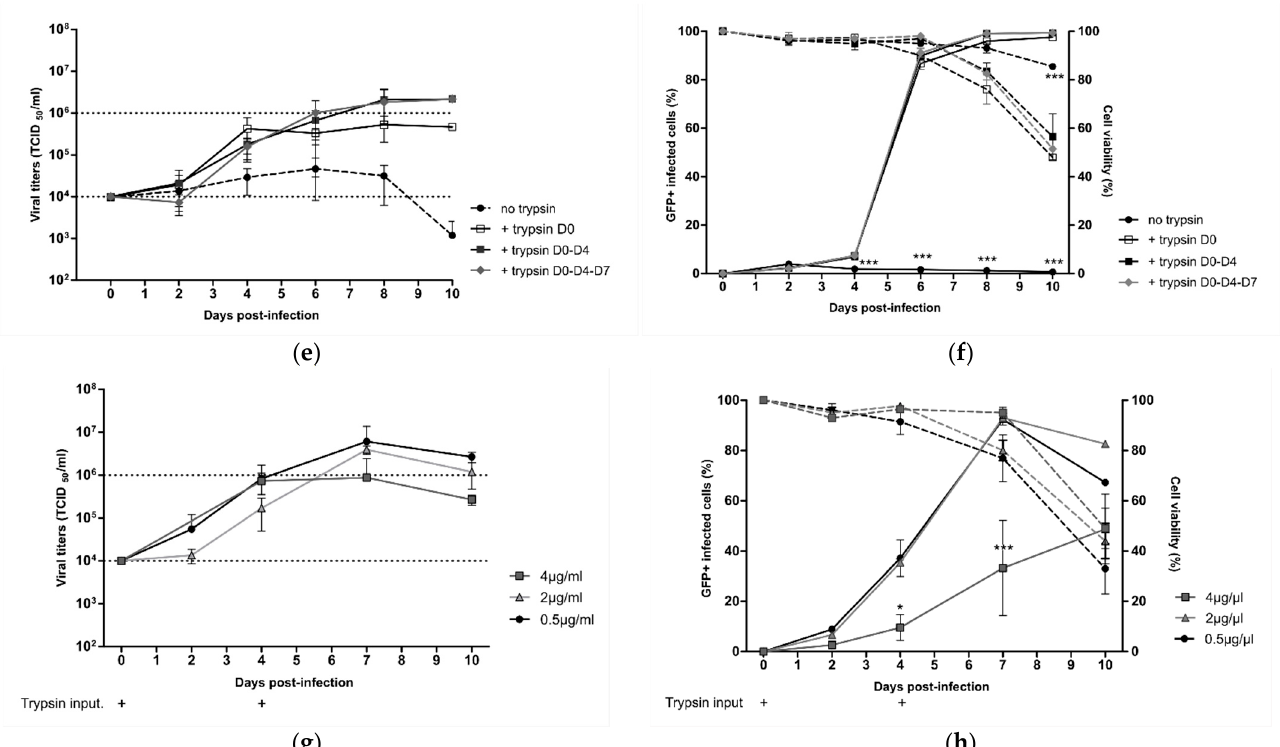
Figure 2. Evaluation of multiplicity of infection (MOI), cell density, trypsin concentration, and optimal timing for trypsin addition on rC-85473-GFP HMPV production kinetics in the DuckCelt ® -T17 cell line. Culture parameters in a 10 mL working volume were separately evaluated by ( a , c , e , g ) viral titration, and (( b , d , f , h ) cell viability and infectivity measurement; dotted line for viability, and solid line for infectivity). Viral titers measured from culture medium as TCID50/mL in LLC-MK2 cells. Viability measured with trypan blue using an automated cell counter. Infected GFP-positive cells evaluated with the FACS CantoII. ( a , b ) Evaluation of MOI of 0.1, 0.01, or 0.001. ( c , d ) Evaluation of three different cell densities at time of infection: 0.5, 1, or 4 × 10 6 cell/mL. (e–f) Evaluation of timing of trypsin addition. Trypsin added at 0.5 µ g/mL at D0, at D0 and D4, or at D0, D4, and D7, or no trypsin was added. ( g , h ) Evaluation of trypsin concentration: 0.5, 2, or 4 µg/mL. Results shown as means ± SD and represent duplicates in two independent experiments. * p < 0.05, *** p < 0.001 when comparing infected conditions to each other using a two-way repeated-measures ANOVA.